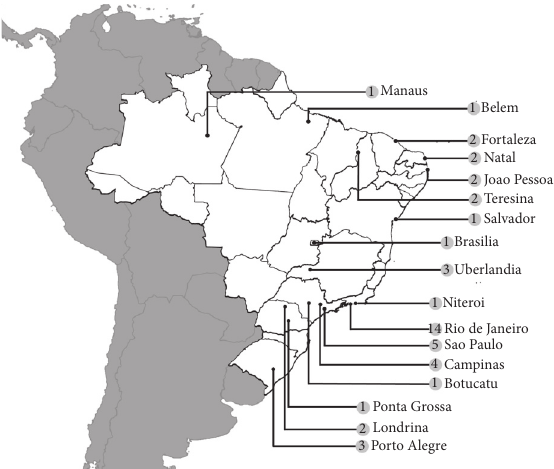
Figure 2: Map with georeference of MRSA reports showing the number of publications by isolation location during the